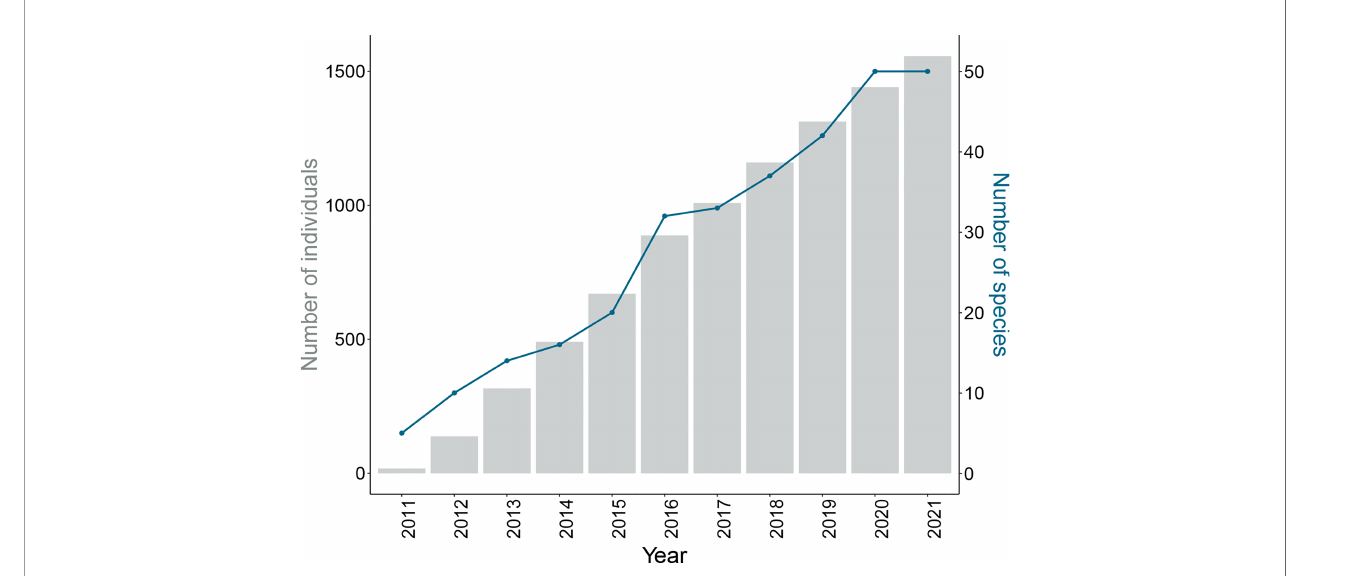
FIGURE 2 | Cumulative number of individuals (grey bars) and species (blue line) tagged with acoustic transmitters per year since the inception of